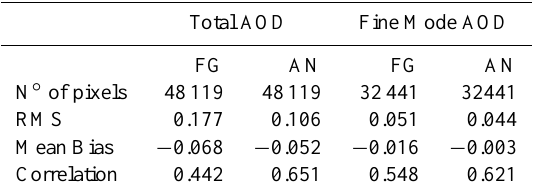
Table 2. Statistics quantifying the difference between first guess (FG) or analysis (AN) and MODIS AOD. The statistics are com- puted at the global scale, considering the full annual cycle and all pixels with observations. The total number of pixels used in the computation of the statistics is given in the first